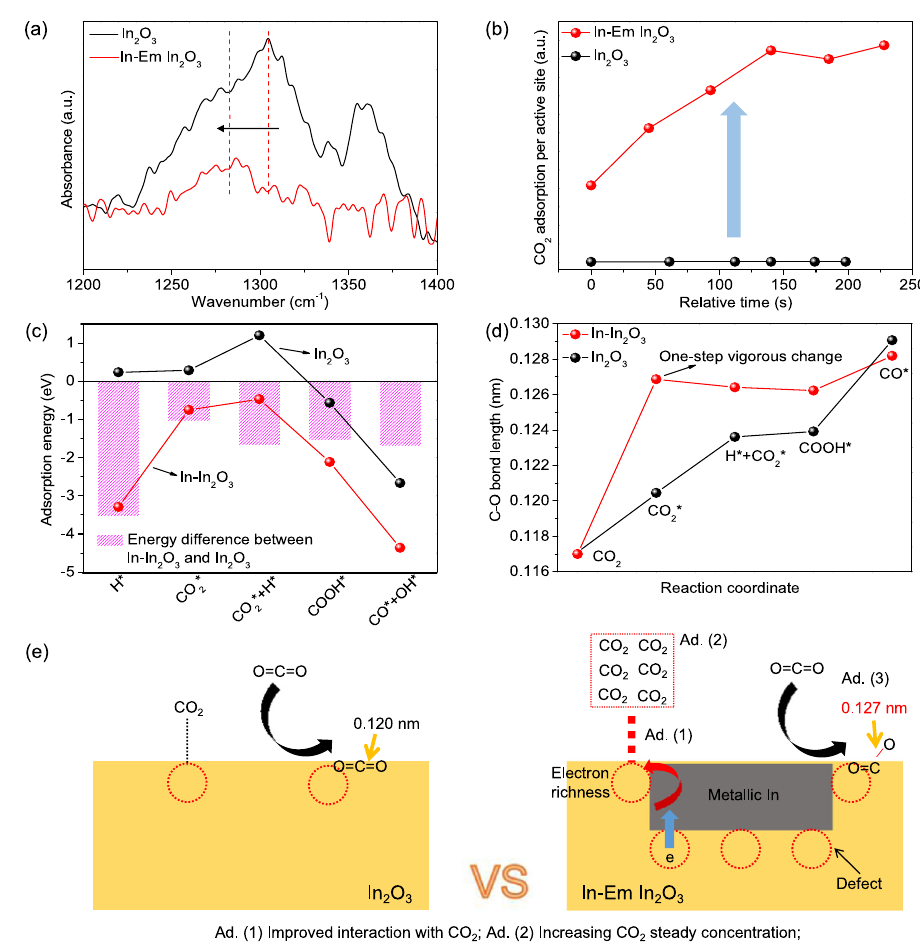
Fig. 5 Enhanced CO 2 adsorption and activation. a FT-IR spectra of CO 2 adsorption in the range of 1200 – 1400 cm − 1 . b Normalized CO 2 adsorption amount by the number of active sites. c Adsorption energies on In 2 O 3 and In – In 2 O 3 . d Change in C – O bond lengths over In 2 O 3 and In – In 2 O 3 . e The schematic picture emphasizes three types of catalytic roles for CO 2 reduction over In-Em In 2 O 3